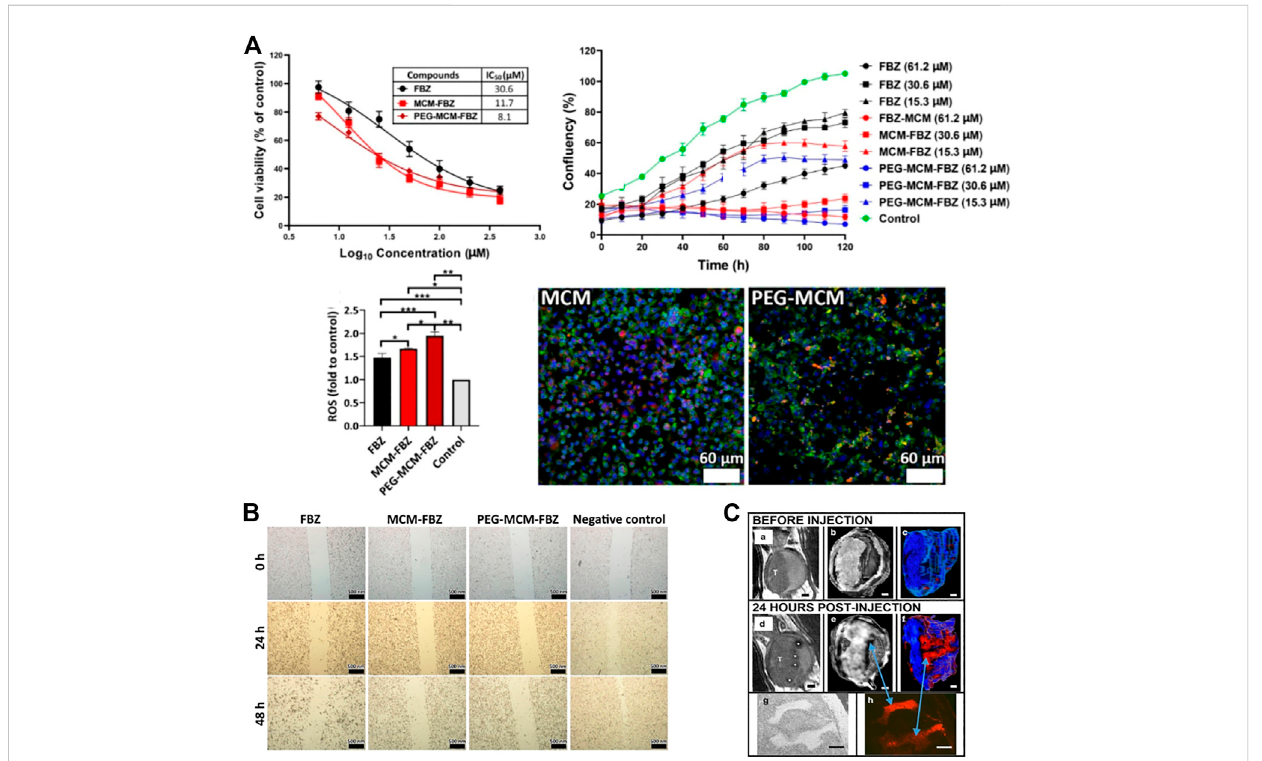
FIGURE 1 Synthesis and applications of mesoporous silica nanoparticles (MSNs). (A) The cytotoxicity of FBZ increased when it was bound the nanomaterial. Moreover, the inhibition of prostate cancer (PCa) cell proliferation was signi fi cantly increased. The intracellular ROS contents were also increased, thus inhibiting the proliferation of tumor cells. Fluorescence experiments showed that the FBZ complexes, especially the PEG-MCM-FBZ complex, increased the uptake of FBZ. (B) The complex effectively inhibits the migration of PCa cells. (C) Bladder tumor cells absorbed PEG-Gd 2 O 3 -TRITC-MSN particles with higher af fi nity than normal bladder epithelial cells and can be used for MRI T2